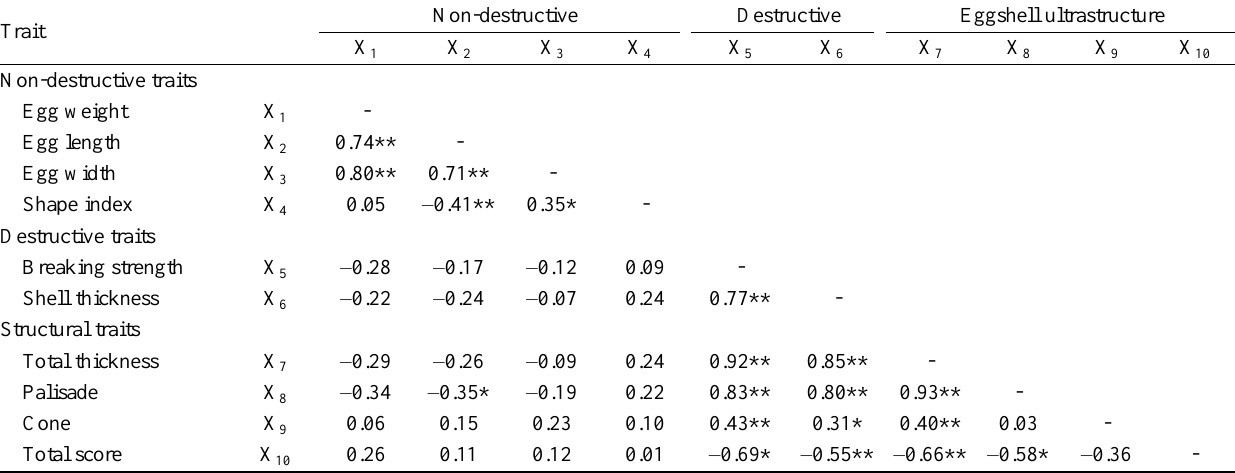
Table 2. Simple correlation coefficients and their level of significance among the traits describing non-destructive, destructive and egg shell ultrastructure